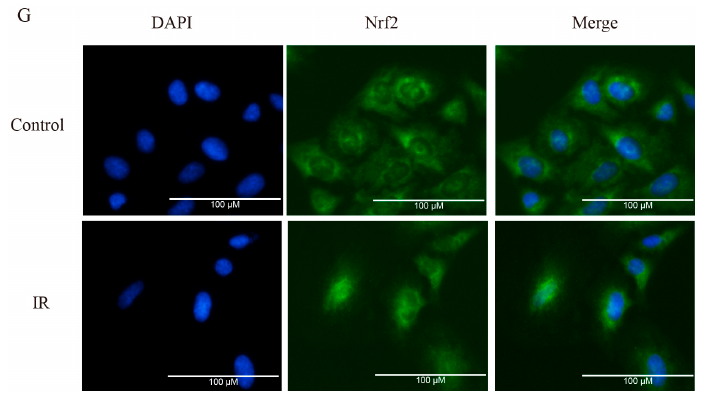
Figure 2. The effects of brusatol on A549 and H1299. ( A , B ) The cytotoxicity of brusatol was determined under the same conditions for the MTT method; ( C , D ) A549 and H1299 cells were treated with the indicated concentrations of brusatol, and were collected after 6 h. Then we extracted total proteins for Western blot analysis; ( E ) A549 cells were treated with, or without, 80 nM brusatol for 4 h, then exposed to 6 Gy γ -irradiation or not. Two hours later, we extracted total proteins for Western blot analysis; ( F , G ) The Nrf2 protein level of A549 cells was determined under the same experimental conditions as in ( E ) using the Immunofluorescence method. (The scale bars in Figure 2F are 200 µM) ** p < 0.01, * p < 0.05.